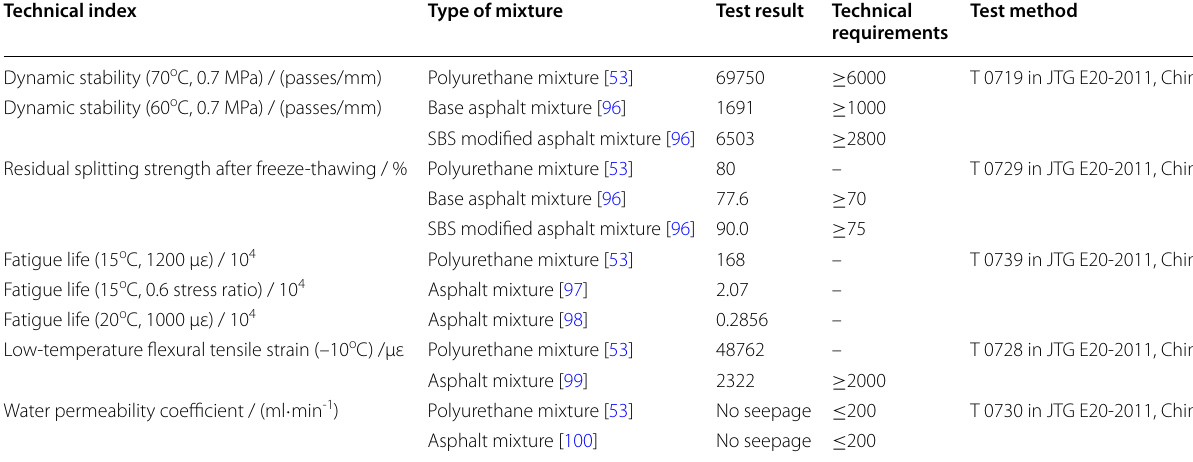
Table 7 The comparison of the road performance between the polyurethane- and asphalt-based bridge deck pavement materials Technical